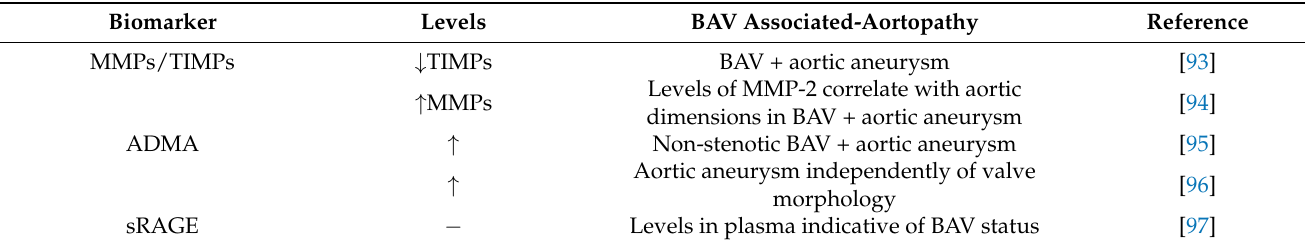
Table 3. Potential biomarkers for the early diagnosis of BAV or its associated aortopathies. Biomarker Levels BAV Associated-Aortopathy Reference MMPs/TIMPs ↓ TIMPs BAV + aortic aneurysm [93]